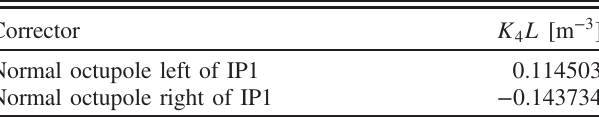
TABLE V. Applied b 4 corrections in IR1 at β (cid:1) 4 TeV. The corrections shown were observed to significantly reduce the second order tune variation of both beams with vertical crossing angle in IP1.